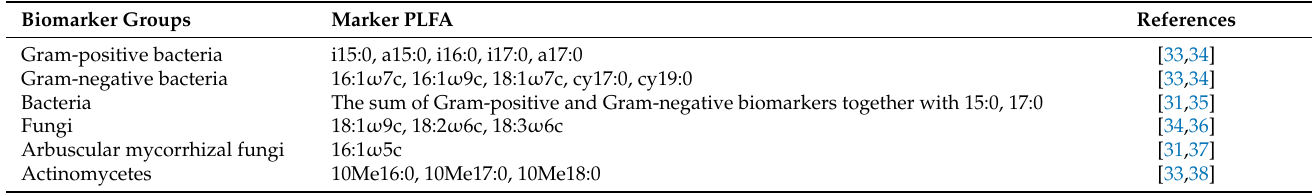
Table 1. Biomarker groups